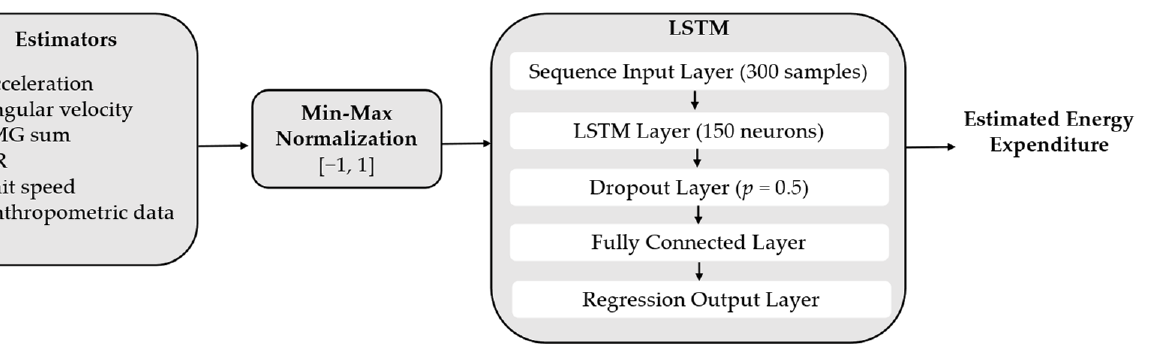
Figure 3. LSTM’s architecture of the final model.